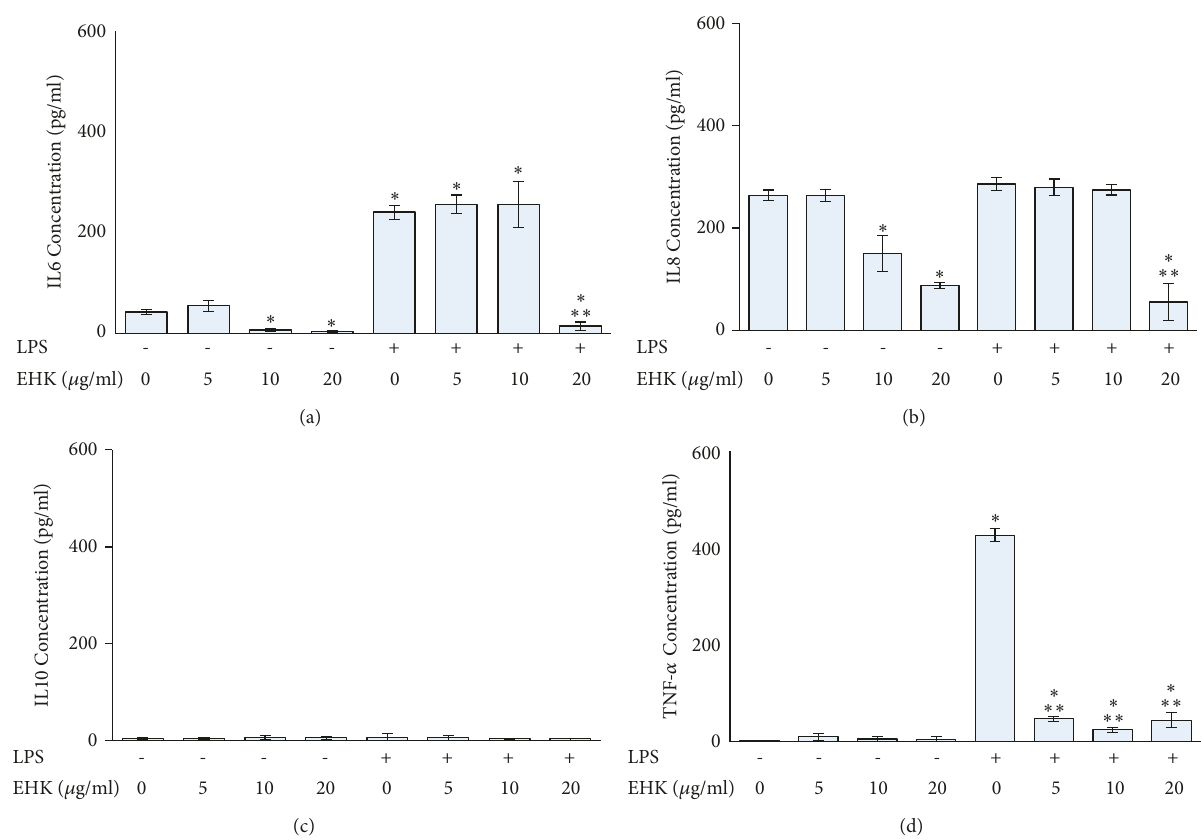
Figure4:TheeffectofEHKonIL6(a),IL8(b),IL10(c),andTNF- 𝛼 (d)productioninPBMCsandLPS-treatedPBMCs.PBMCswereseparated using Ficoll-Paque density centrifugation, seeded in 12-well plates, and treated with 10 𝜇 g/ml LPS and EHK at the indicated concentrations for 24 h. The levels of IL6, IL8, IL10, and TNF- 𝛼 secretion were determined using ELISA with specific antibodies to each cytokine. ∗ p < 0.05 compared to control group; ∗∗ p < 0.05 compared to LPS-treated group